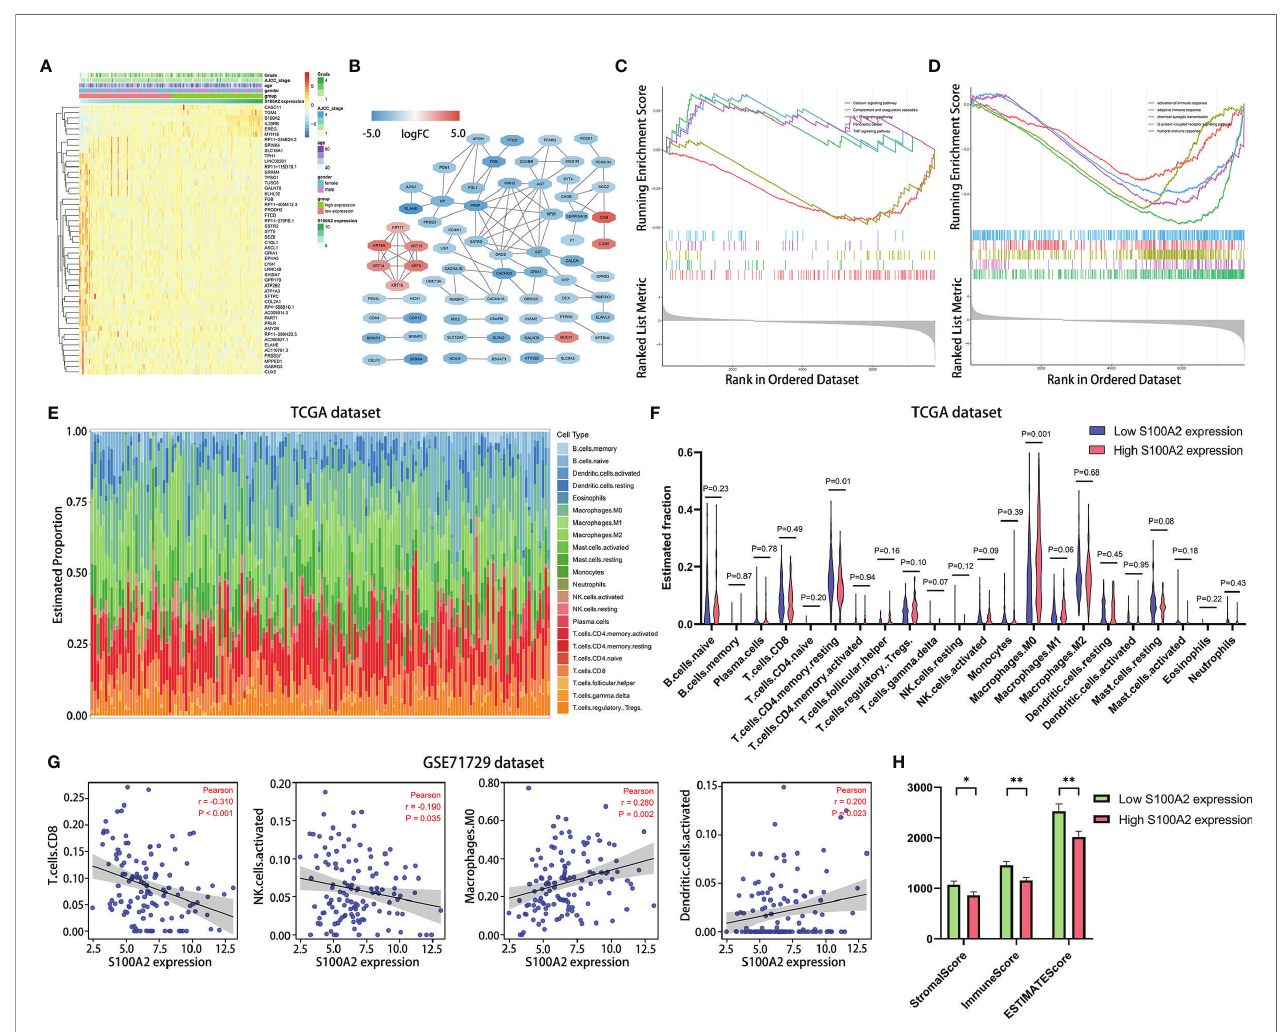
FIGURE 6 | Differential gene analysis, co-expression network construction and functional enrichments analysis between S100A2 high and low expression groups, as well as the correlation analysis of the expression of S100A2 and immune cell in fi ltration. (A) Heatmap of top 50 DEGs in PC between S100A2 high and low expression groups. (B) Co-expression network of DEGs constructed and visualized with STRING database and Cytoscape. (C, D) Gene Set Enrichment Analysis between S100A2 high and low expression groups. The representative 5 KEGG enrichments (C) and GO enrichments (D) were displayed respectively. (E) The abundance ratio of the 22 types of immune cells in TCGA entire set. (F) Differential immune cell type abundance between S100A2 high and low expression groups. (G) Correlation analysis between the expression of S100A2 and the proportion of immune cells in GSE71729 dataset. Immune cell types with P < 0.05 were shown. (H) Differences in immune scores between high and low S100A2 expression groups. *P < 0.05; **P <